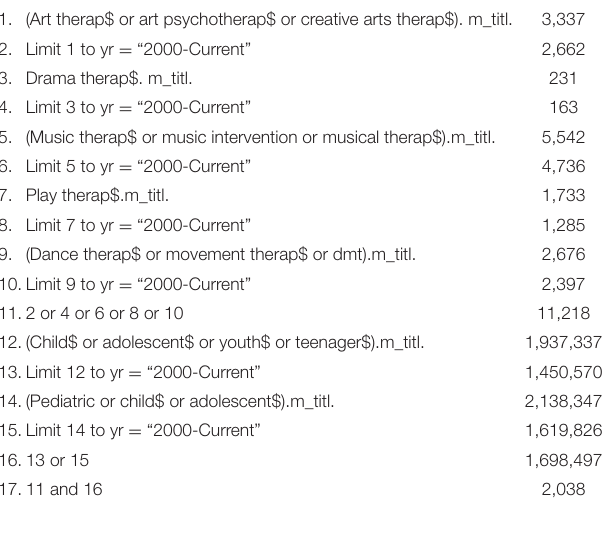
Table A1 | Search strategy used for the EBSCO interface and Medline